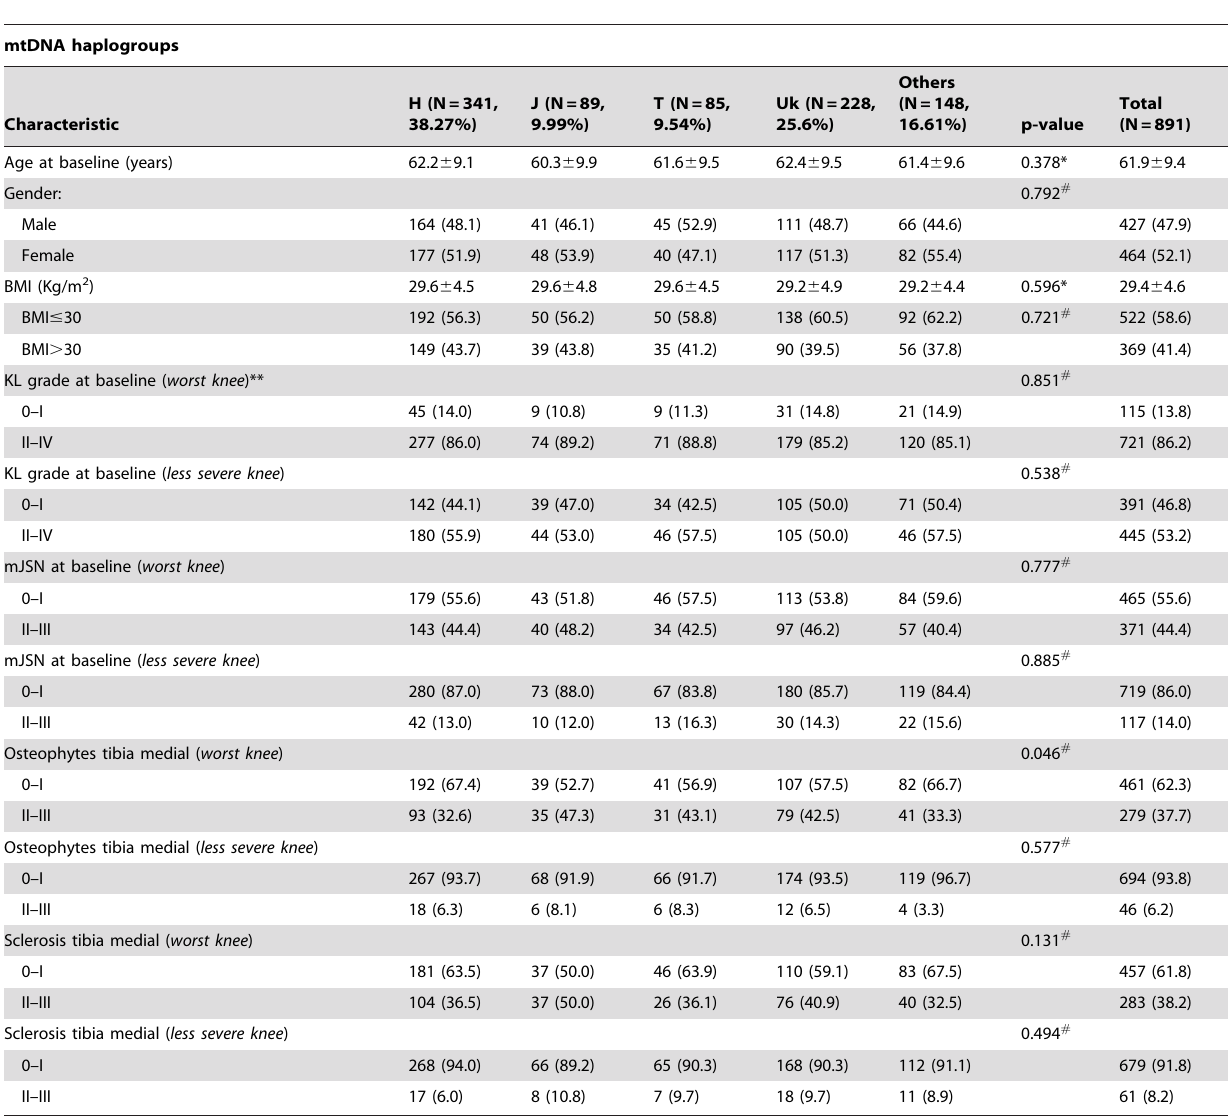
Table 1. Demographic characteristics of the study population at baseline grouped by mitochondrial DNA (mtDNA) haplogroups in the progression subcohort of the